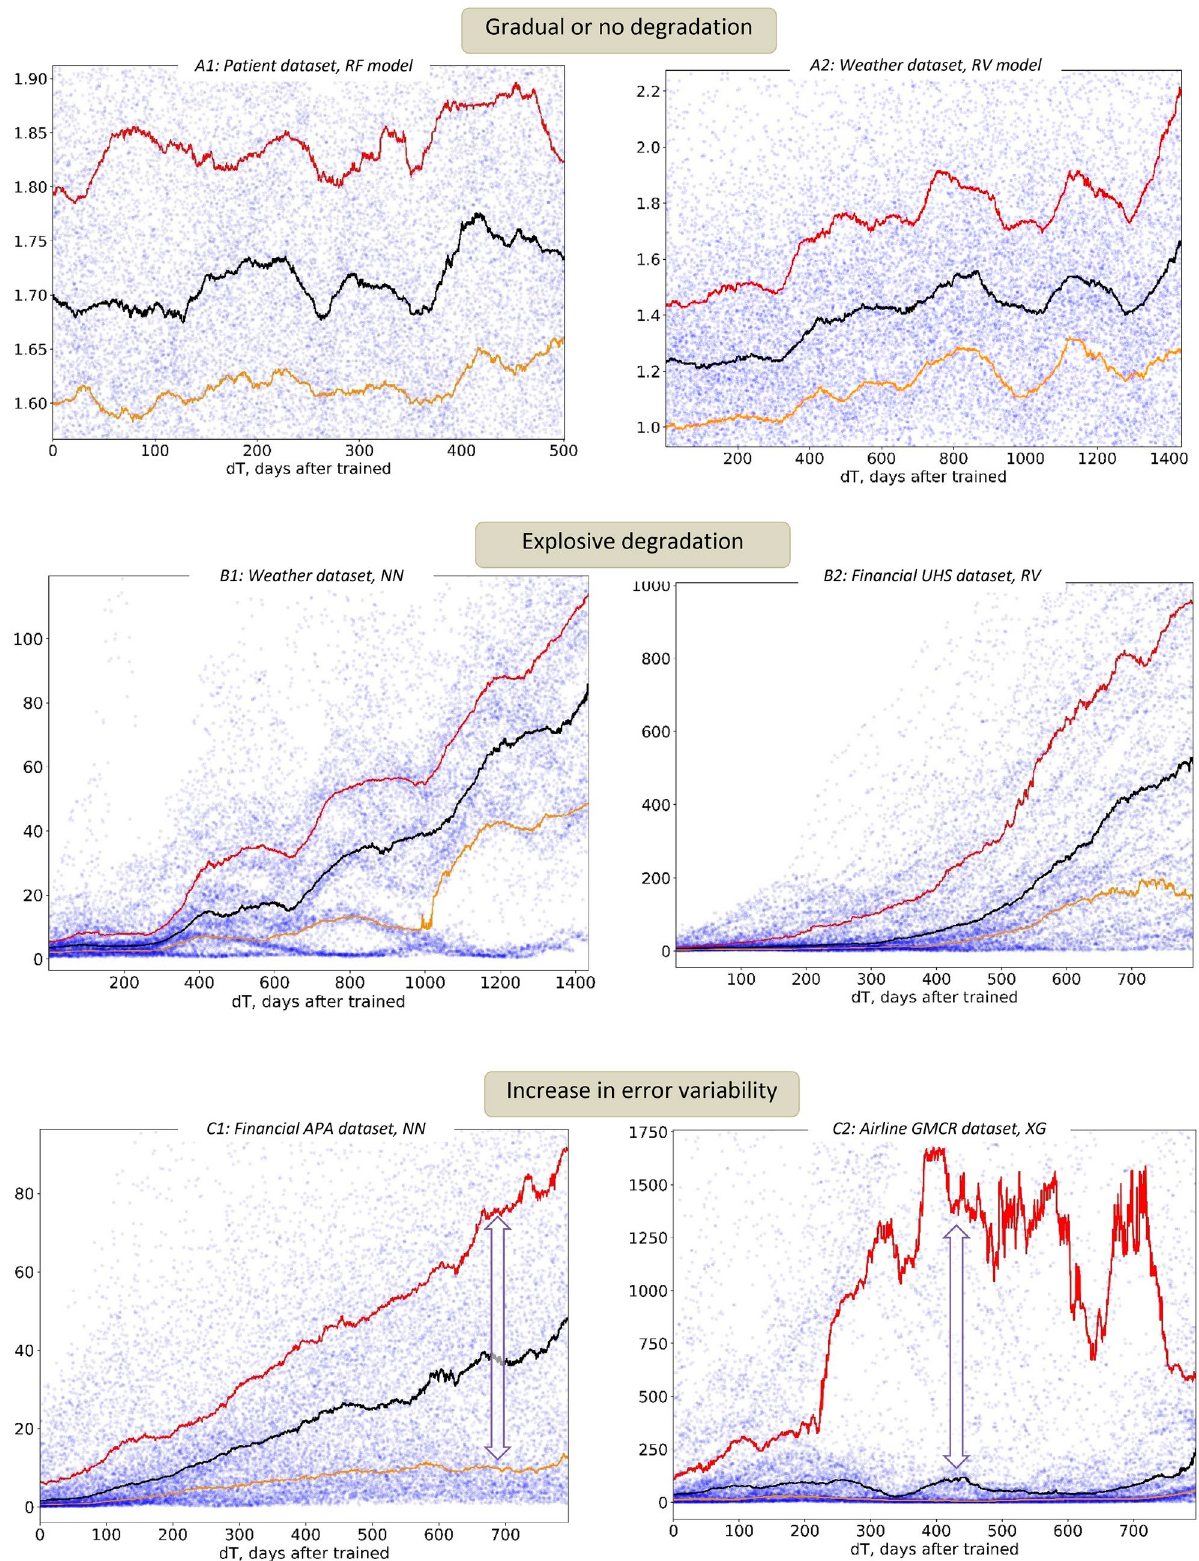
Figure 3. ( A ) Gradual AI model degradation patterns, with relative model error E rel increasing no faster than linearly over time. Note that occasional reversal of aging (decrease in E rel values) is possible as well. ( B ) Explosive AI model aging patterns (in data with very moderate and predictable growth). ( C ) Increasing unpredictability AI model aging patterns (in data with very moderate and predictable